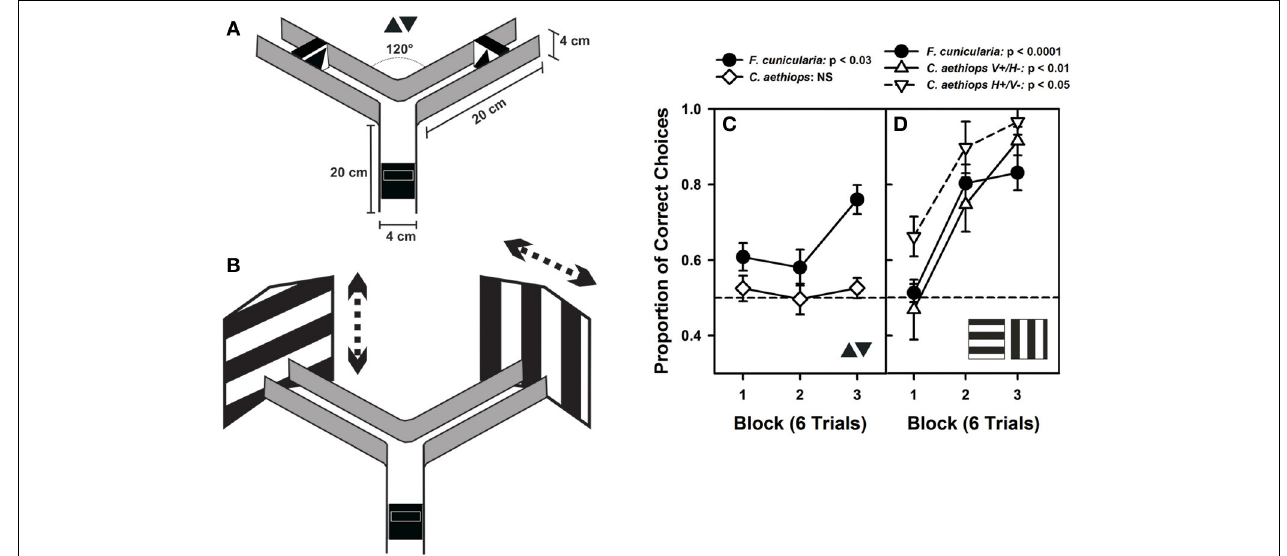
FIGURE 5 | Visual performances of F. cunicularia and C. aethiops . (A) The Plexiglas Y-maze used for visual discrimination learning in ants. The maze presents the two small-field visual stimuli that ants had to learn to discriminate, a small black triangle pointing upward and another black triangle pointing downward, both presented on a white background. (B) Visual discrimination learning of two large-field visual stimuli in the form of two large black-and-whitegratings,onehorizontalandtheothervertical,whichexceeded the extent of the maze back walls. Gratings had stripes 8cm in width and were randomly shifted (see dashed arrows) from visit to visit to prevent the